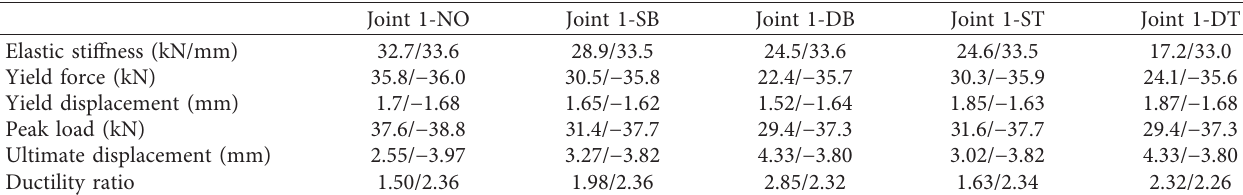
Figure 16: Comparisons of skeleton curves for Joint Table 3: Summary of the mechanical parameters of Joint 1.